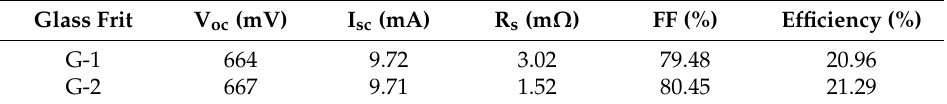
Table 2. I-V cell characterization results.